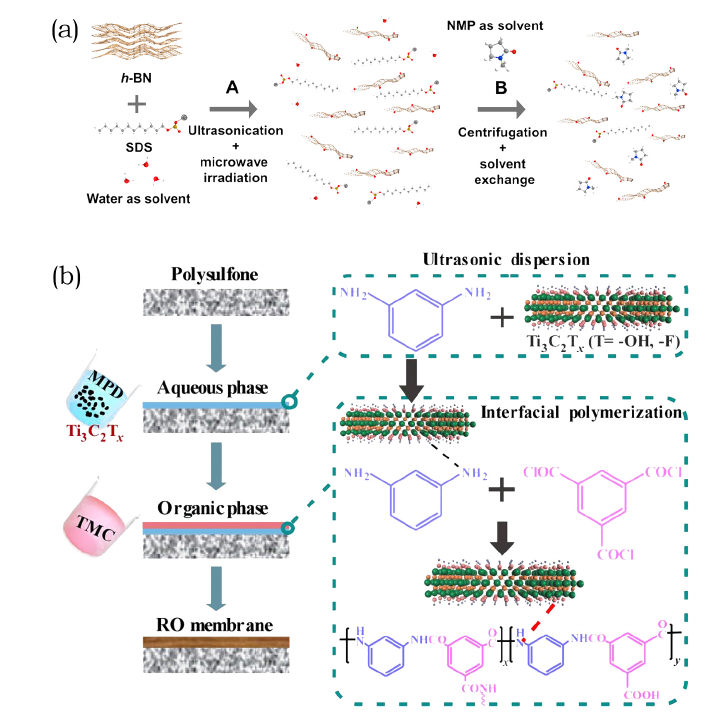
Figure 5. ( a ) The exfoliation process of boron nitride nanosheets from their bulk counterparts. Reprinted from [29], Copyright (2018), with permission from Elsevier. ( b ) Fabrication steps of Ti 3 C 2 T x Thin Film Nanocomposite (TFN) membranes via interfacial polymerization of m-phenylenediamine(MPD)